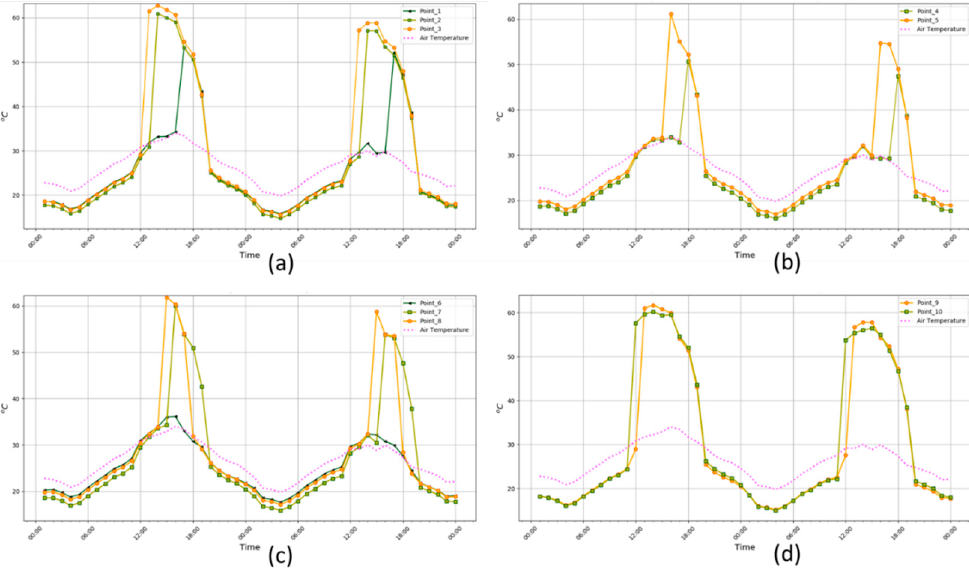
Figure 12. The temporal and spatial distribution of hourly Tmrt for focal spots in the urban spaces demonstrated in Figure 10a; ( a ) points (1,2,3); ( b ) points (4,5); ( c ) points (6,7,8); ( d ) points